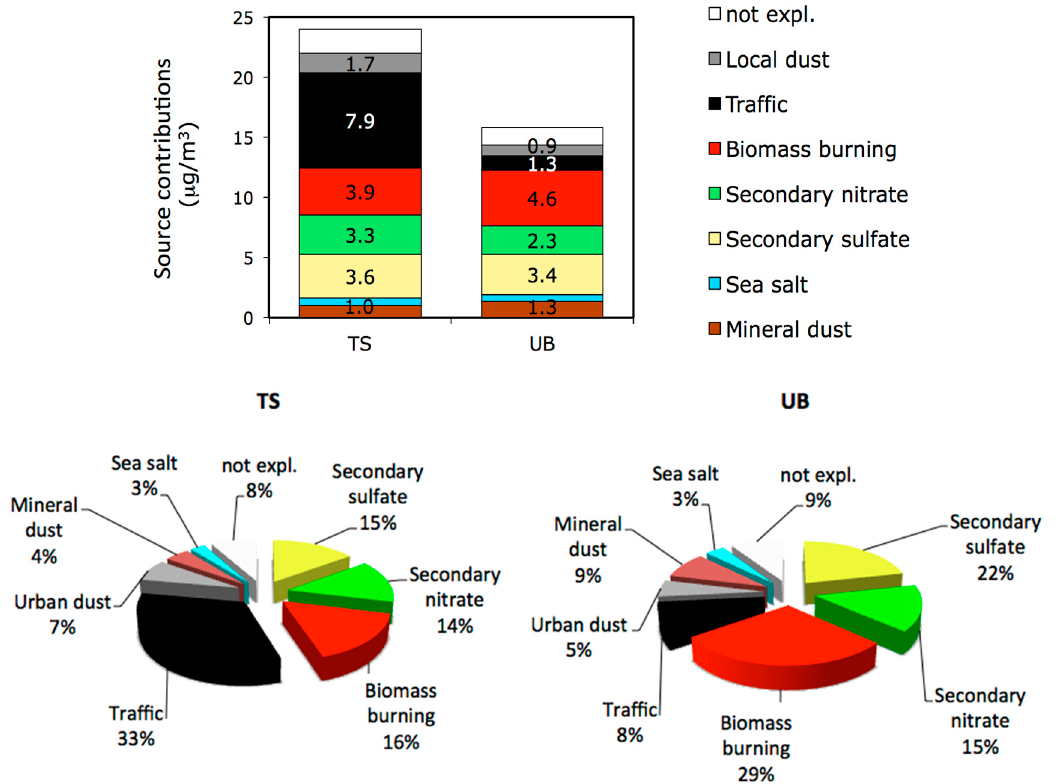
Figure 4. PM 2.5 source apportionment obtained by positive matrix factorisation (PMF): annual average contributions of the identified sources, in the TS and UB sampling sites of Florence (absolute values, above, and percentage contributions, below).